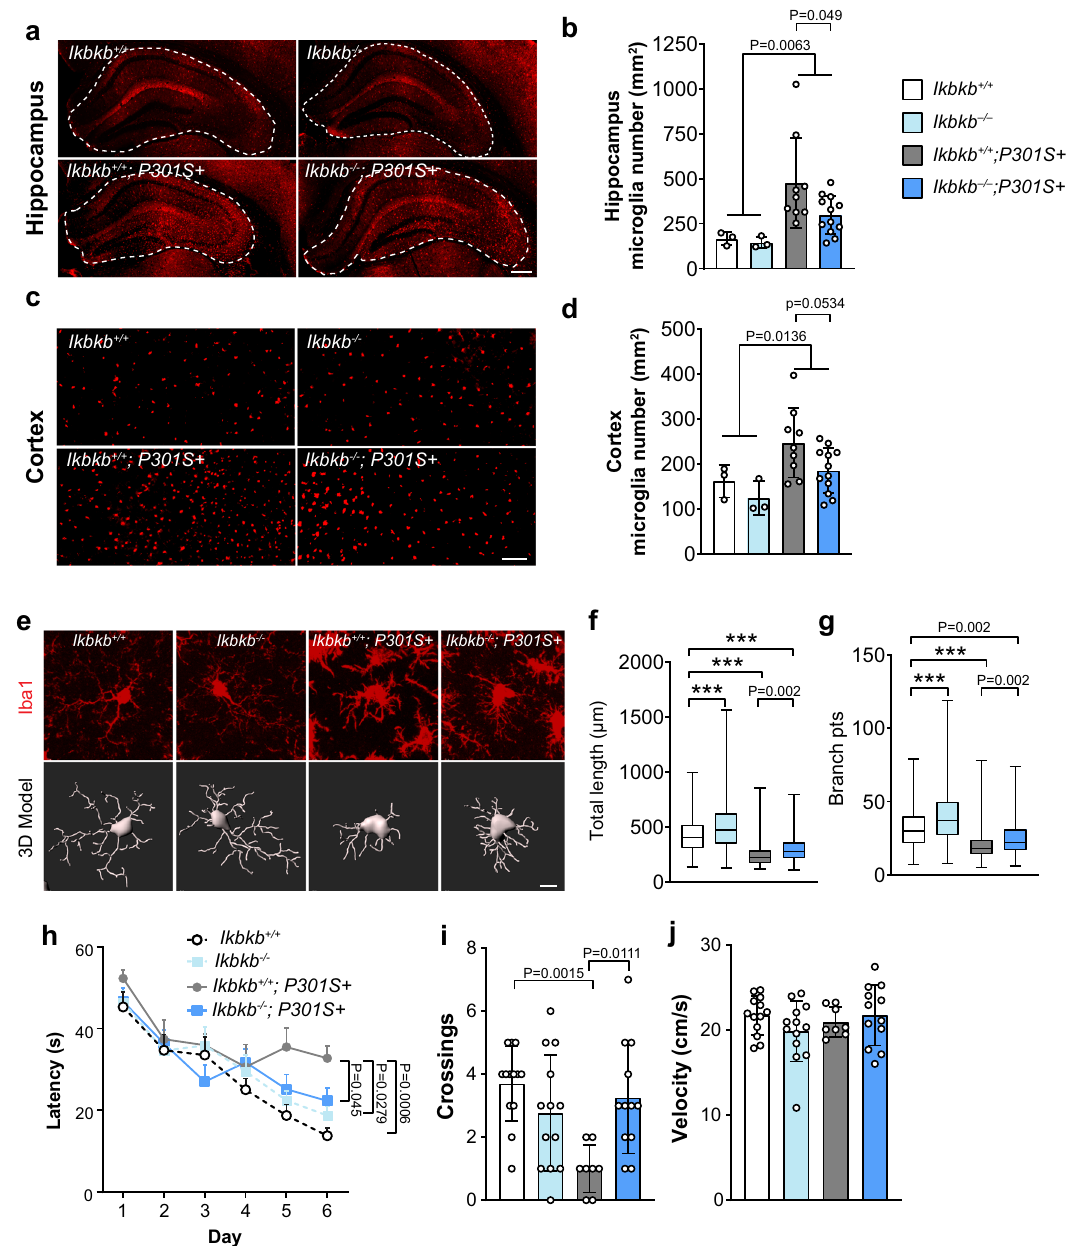
Fig. 5 Inactivation of microglial NF- κ B partially rescues microgliosis, morphological alterations and protects against spatial learning and memory de fi cits in PS19 mice. a – d Representative immunohistochemical staining ( a , c ) and quanti fi cation ( b , d ) of Iba1 + microglia in the hippocampus ( a , b ) and cortex ( c , d ) of Ikbkb + / + ( n = 3), Ikbkb − / − ( n = 3), Ikbkb + / + ; P301S + ( n = 9), and Ikbkb − / − ; P301S + ( n = 12) mice. Scale bar, hippocampus 250 μ m, cortex 100 μ m, values are mean ± SD, two-way ANOVA with Sidak ’ s multiple comparisons post-test. e Representative immunohistochemical confocal images showing morphological features of microglia from the hippocampus of Ikbkb + / + , Ikbkb − / − , Ikbkb + / + ; P301S + , and Ikbkb − / − ; P301S + mice and the corresponding 3D reconstructions using Imaris. Scale bar, 10 μ m. f , g Quanti fi cation of the total length of microglial processes ( f ) and the number of microglia process branch points ( g ). N = 4 mice per genotype (four sections per mouse) were imaged and a total of 893 ( Ikbkb + / + ), 902 ( Ikbkb − / − ), 3455 ( Ikbkb + / + ; P301S + ), and 2143 ( Ikbkb − / − ; P301S + ) microglia were analyzed. Values are shown as boxplot. The box extends from the 25th to 75th percentiles with the median is shown in the middle of box. Whiskers show from the smallest value to the largest. P -values were calculated using multilevel mixed-effect model with mouse and section as hierarchical levels, *** P < 0.001. h – j Morris Water Maze test was performed using Ikbkb + / + ( n = 13), Ikbkb − / − ( n = 13), Ikbkb + / + ; P301S + ( n = 8), and Ikbkb − / − ; P301S + ( n = 12) mice. h Escape latency was plotted against the training days; i Times of crossing the platform location in the 72 h probe trial; j swimming speed. Values are mean ± SD, two-way ANOVA with Tukey ’ s multiple comparisons post-test. Source data are provided as a Source data fi